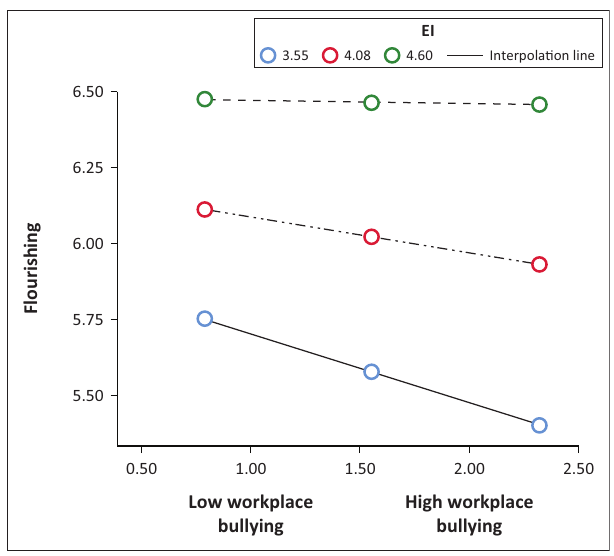
FIG URE 2: Interactive effect between workplace bullying and emotional intelligence in the prediction of